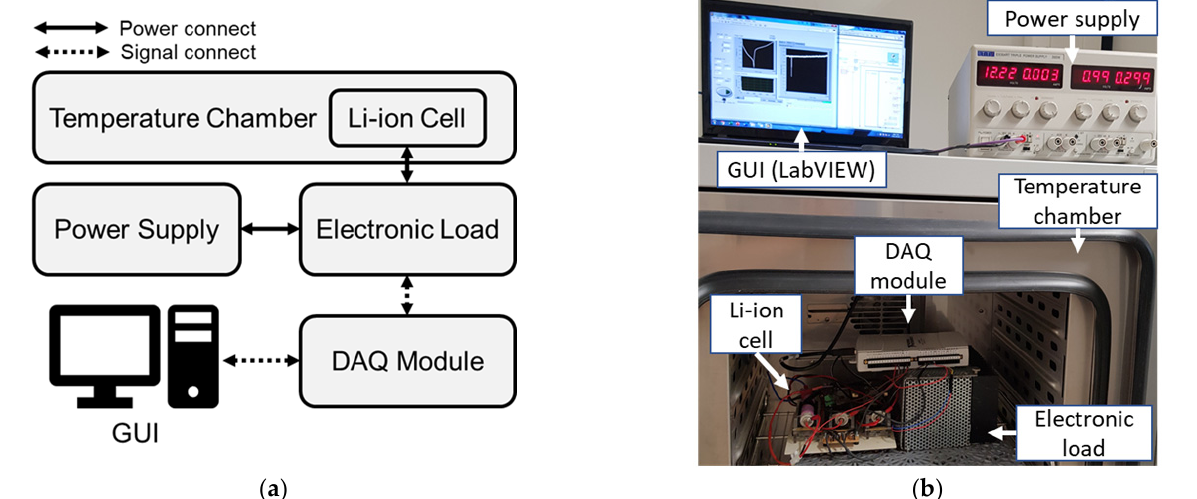
Figure 1. ( a ) A block diagram of the measurement system; ( b ) a photo of the measurement system.